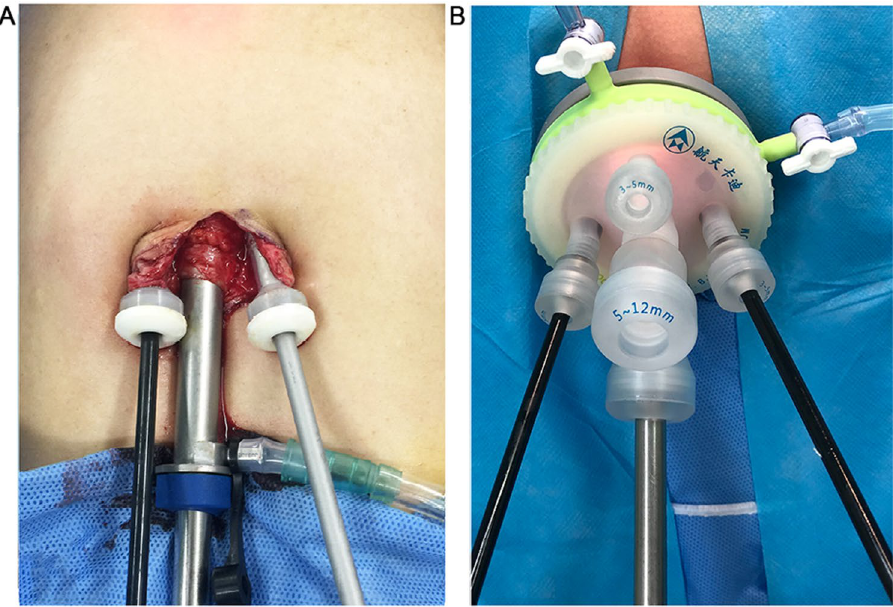
Figure 1. Placement of the laparoscopy platform. ( A ) Single-incision three-channel laparoscopy platform. ( B ) Multichannel-tipped single-port laparoscopy platform (HangT